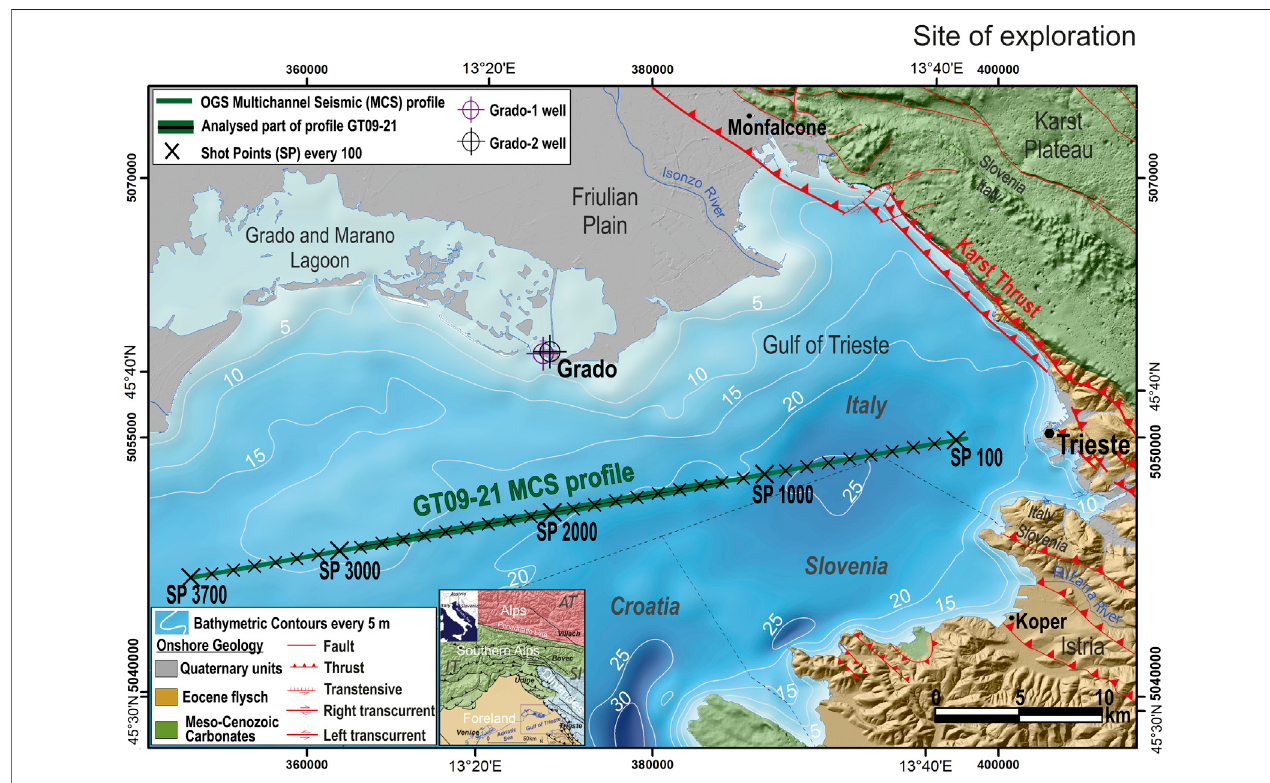
FIGURE1| Locationmapoftheseismicpro fi leGT09 – 21(greenline)withshotpoints(SP)every100(blackcrosses)acquiredbyOGSintheGulfofTrieste(Adriatic Sea).CirclesshowpositionofGradogeothermalwells.Bathymetryindepthwithcellsof50 m,griddingperformedbyZampa(2020)byusinggridsfromItalyandSlovenia (Trobec et al., 2018) and Croatia (EMODnet Digital Bathymetry, 2018). Onshore geology is represented for Friulian Plain and Italian Karst Plateau (Cucchi et al., 2013), Slovenian Karst Plateau (Jurkov ˇ sek et al., 2016) and Istria (Placer et al., 2010). Digital Elevation Model compiled for Italy (10 m cells; IRDAT-FVG, 2017), Slovenia (10 m cells; Arso, 2017) and Istria (25 m cells; EU-DEM, 2017). Inset: chains and foreland domains of the region surrounding the Gulf of Trieste. Map compiled by using ArcGis ® software by Esri; datum WGS84, projection UTM33.